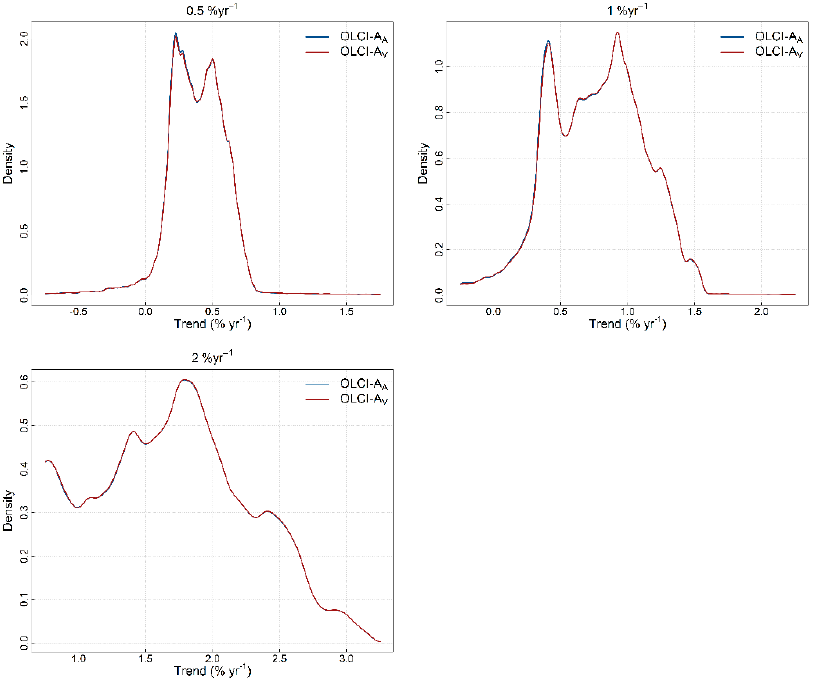
Figure A1. Histograms of all chl- a trends estimated in all 1 ◦ grid cells and all bootstraps for OLCI-A-Aligned and OLCI-A-Vicarious. This shows that OLCI-A-Aligned and OLCI-A-Vicarious both show very similar distributions of chl- a trends, except that OLCI-A-Aligned has slightly smaller variance, which applies to all input trends.